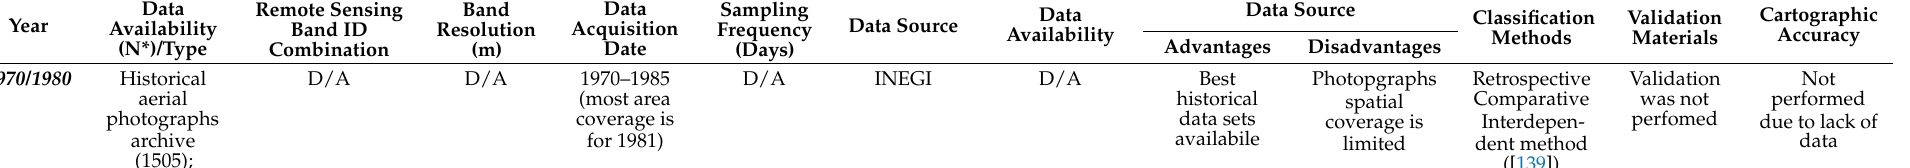
Table 1. Description of materials used to produce the original SMMM cartography from 1970–2020. D/A = do not apply; (N*) = number of images/data sets; INEGI: Instituto Nacional de Estad í stica y